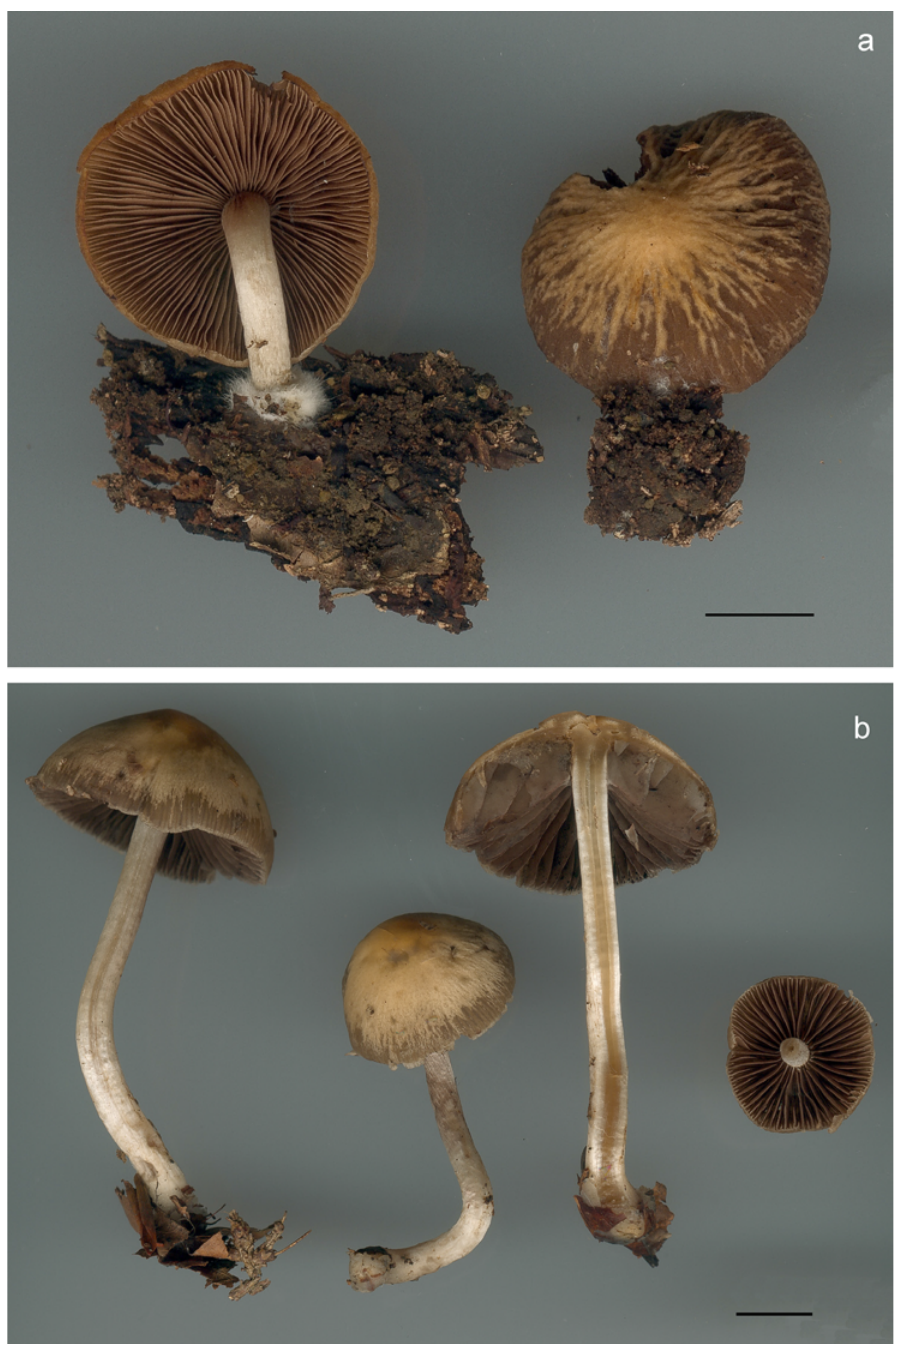
Fig. 4a – Psathyrella hydrophiloides Kits van Wav., coll. KRAM F-54446; b – Psathyrella murcida (Fr.) Kits van Wav., coll. KRAM F-50386; scale bar = 10